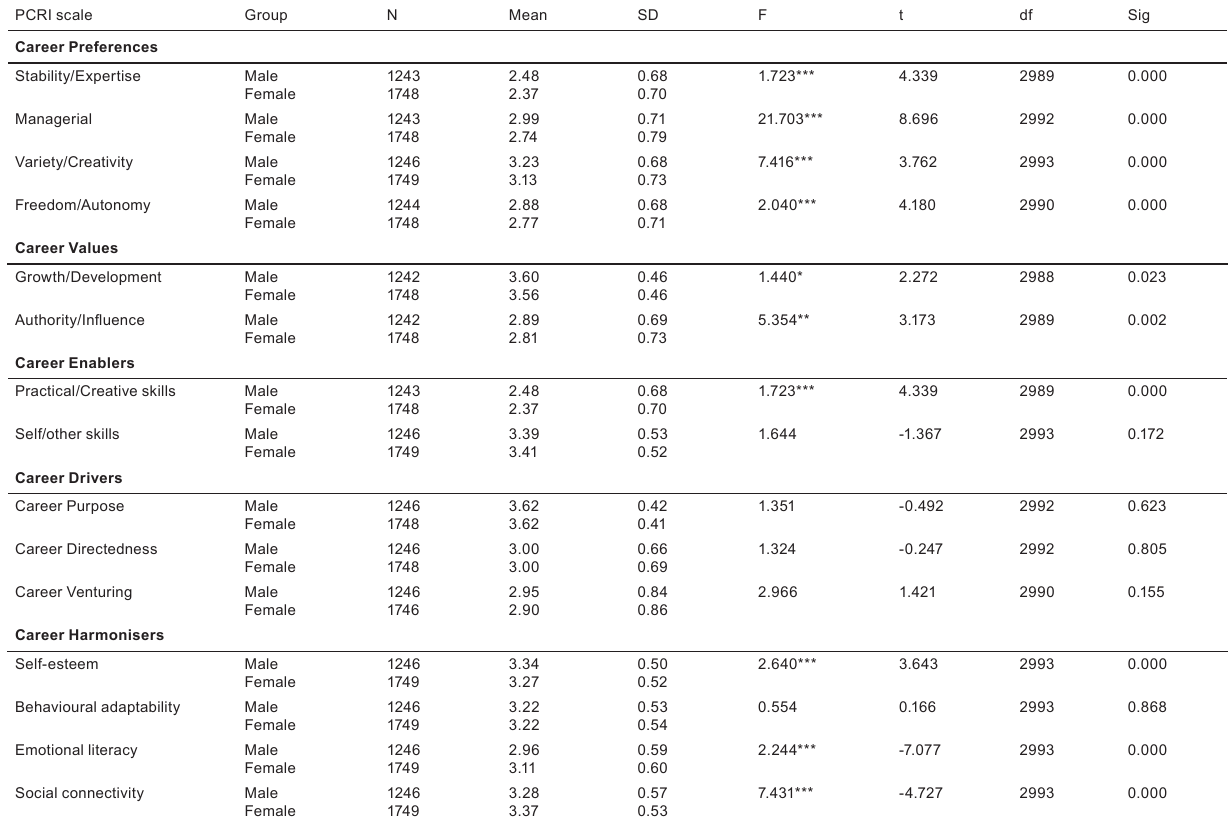
Table 5 Summary: Independent samples t-test for